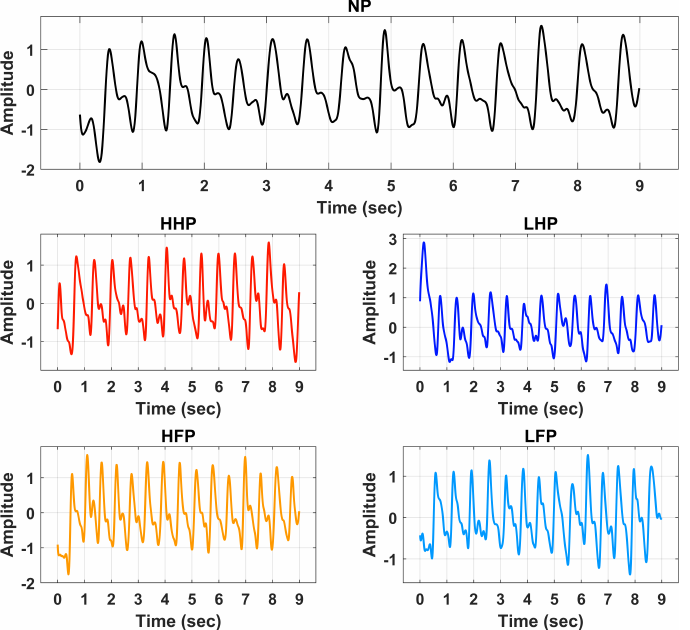
Figure 3. Processed signals of No Pain (NP), High Hand Pain (HHP), High Forearm Pain (HFP), Low Hand Pain (LHP), and Low Forearm Pain